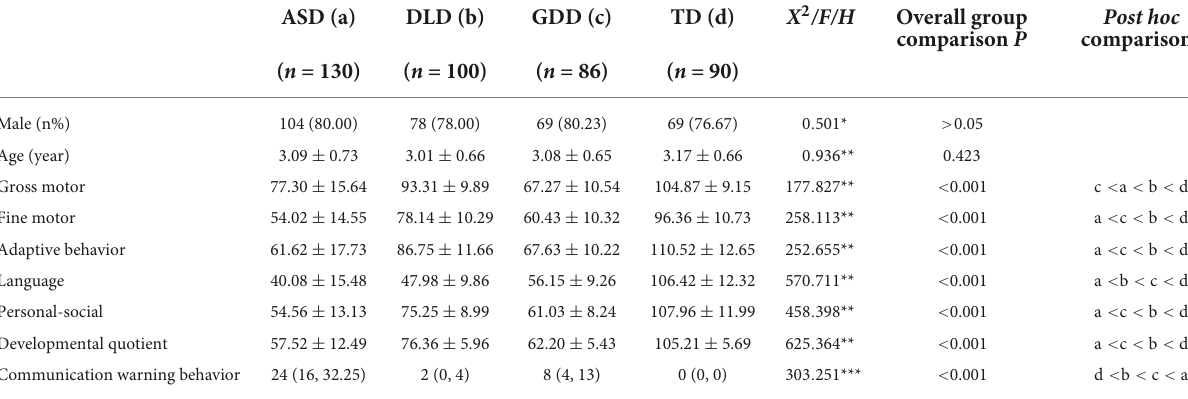
TABLE 1 Demographics and developmental levels of participants.